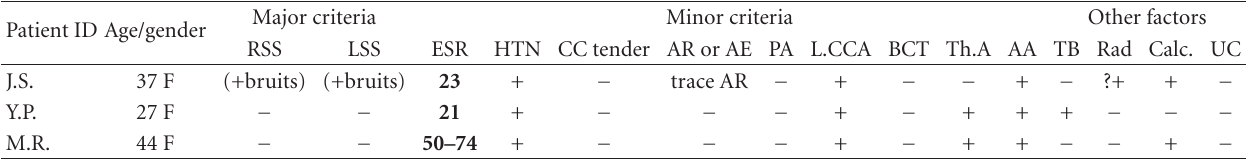
Table 1: Clinical summary of three Hispanic patients with Takayasu’s